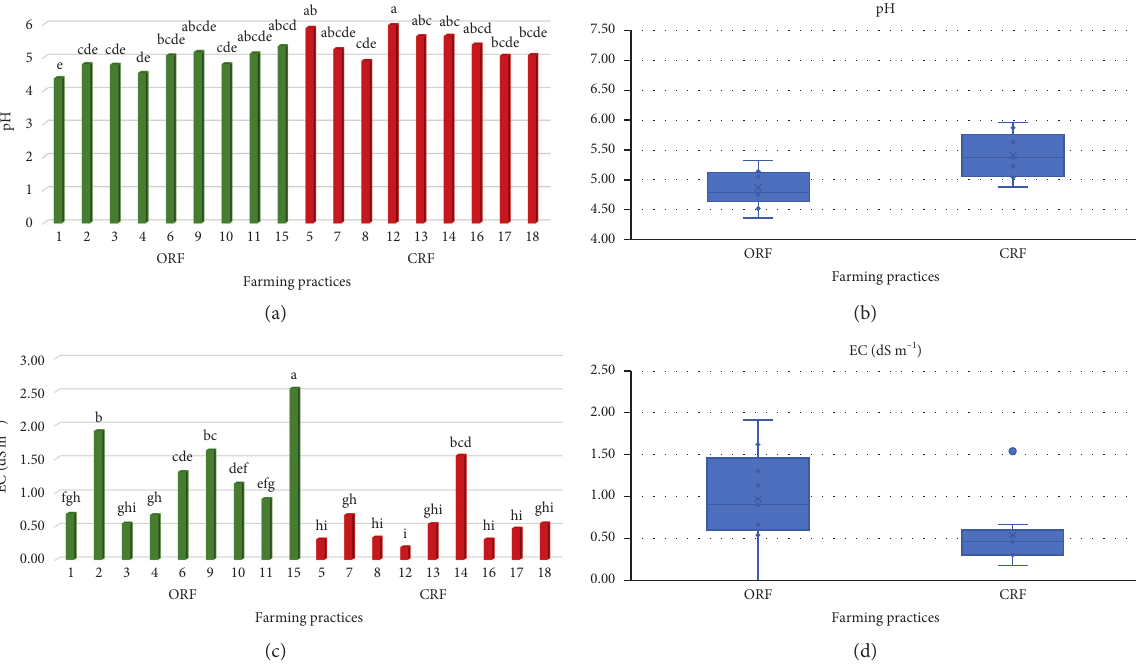
Figure 3: The soil pH value (a, b) and electrical conductivity (c, d) of the soils in organic and conventional farming systems (ORF and CRF, respectively). The error bars represent the standard deviation of measurements for nine soil